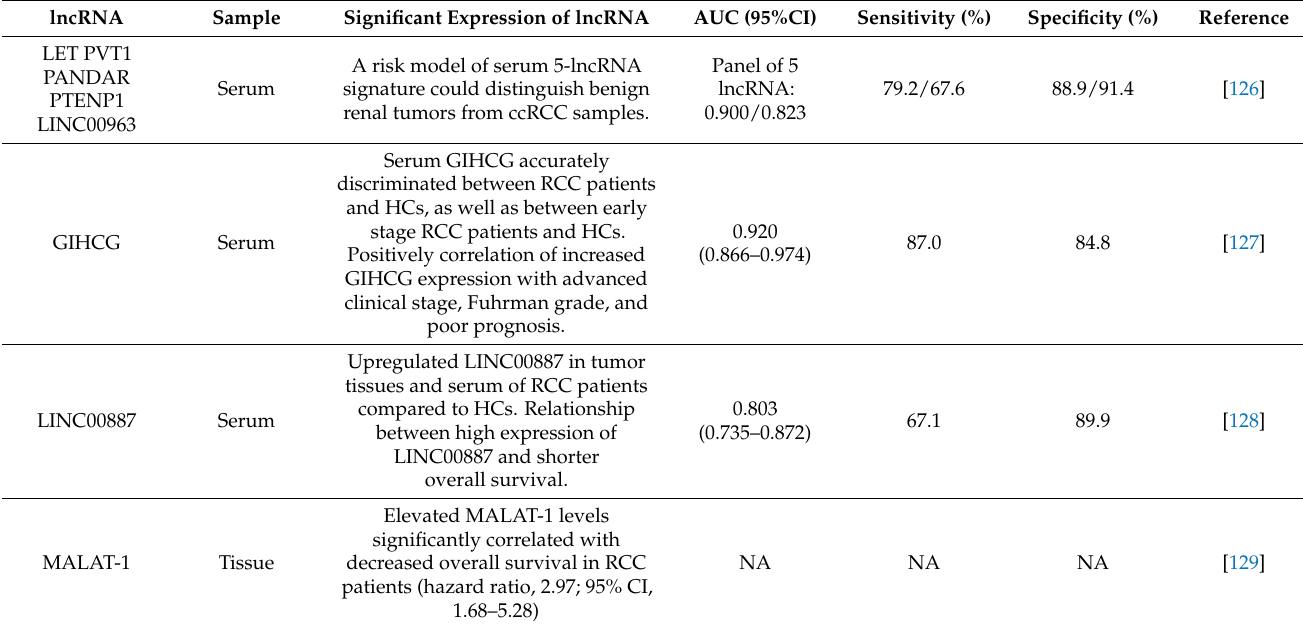
Table 3. lncRNAs as potential diagnostic biomarkers in